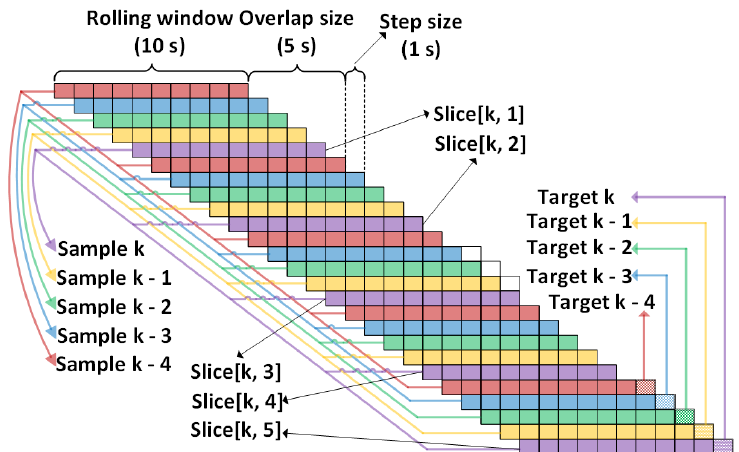
Figure 2. Schematic representation of windowing applied to different